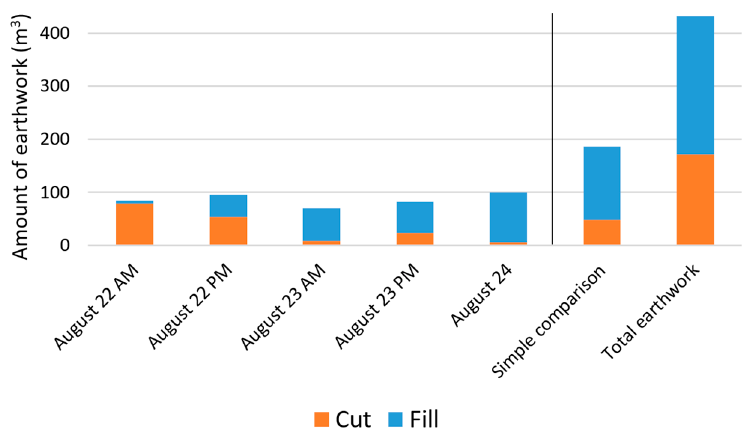
Figure 6. Amount of earthwork for cut and fill at each stage.